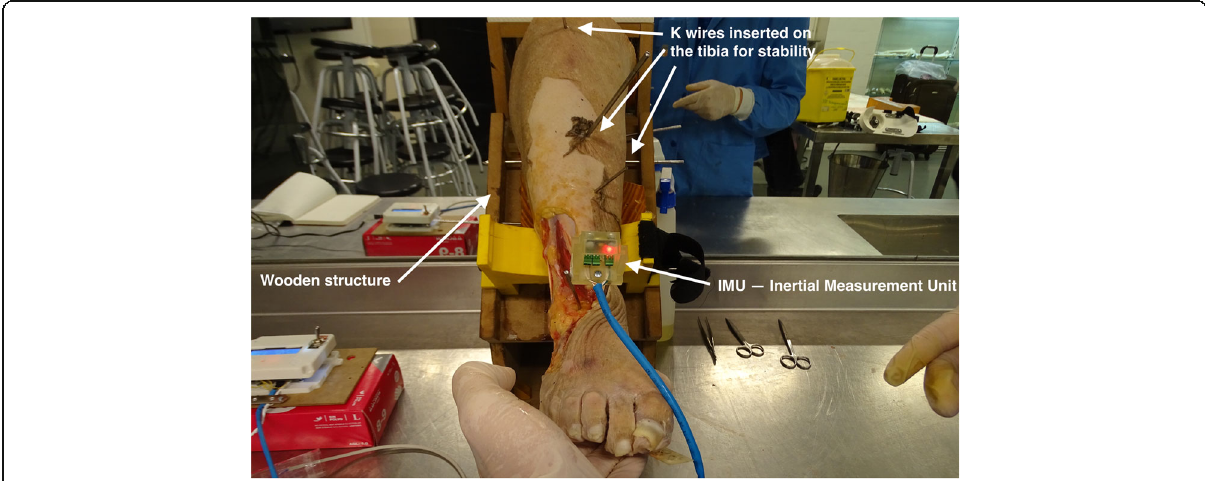
Fig. 2 Description of the device components. Image of the experimental setting on a specimen